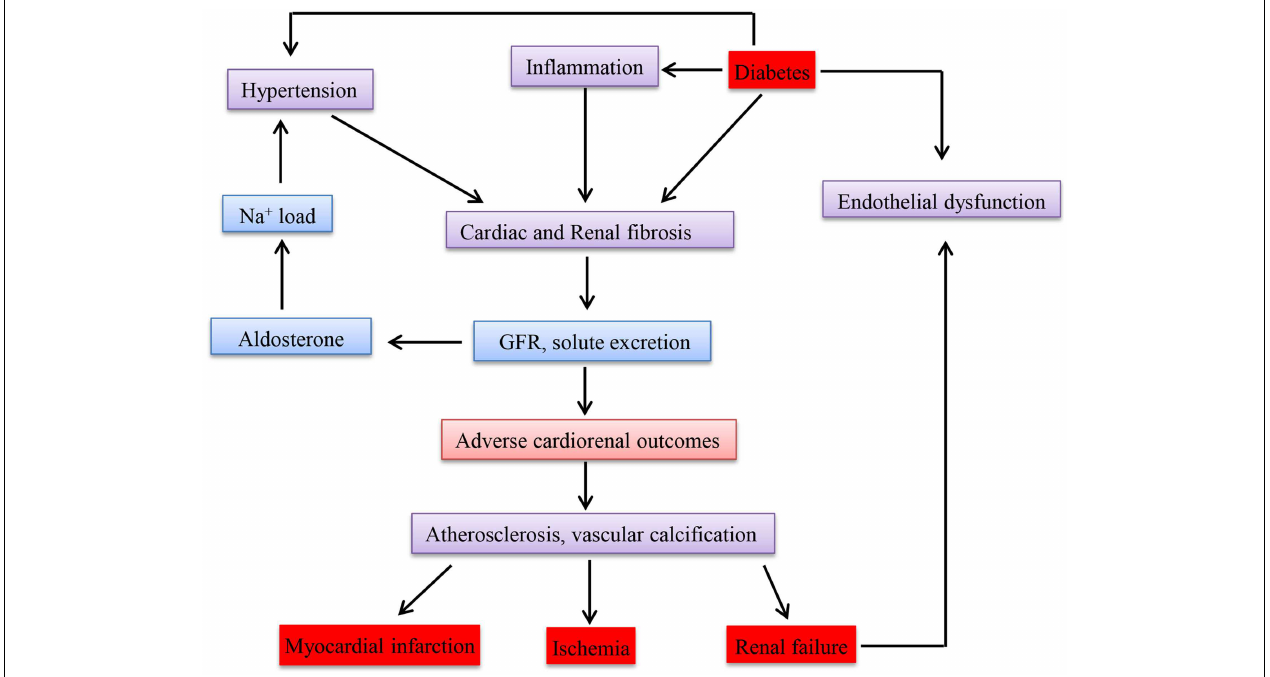
FIGURE 3 | Schematic representation of clinical link between chronic kidney disease, diabetes mellitus, and cardiovascular disease .